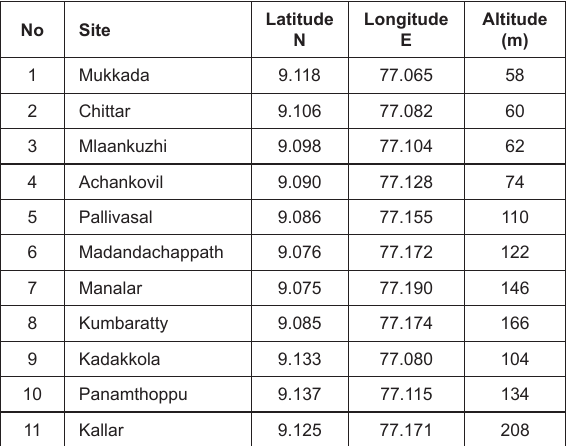
Table 1. Details of sampling sites in Achankovil Reserve